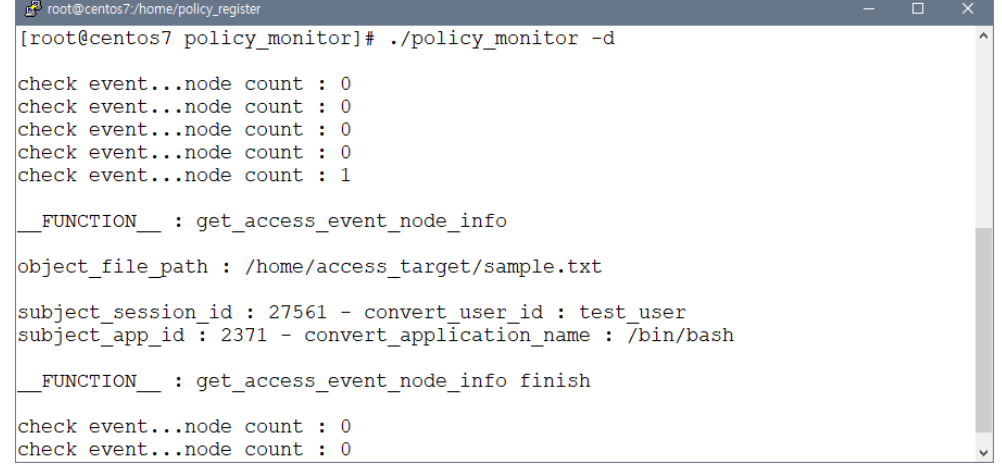
Figure 8. Event monitor’s notification function verification. The event monitor checks the file access event node in the kernel periodically. When the event monitor confirms that the file access event node is generated, it notifies the file access event.